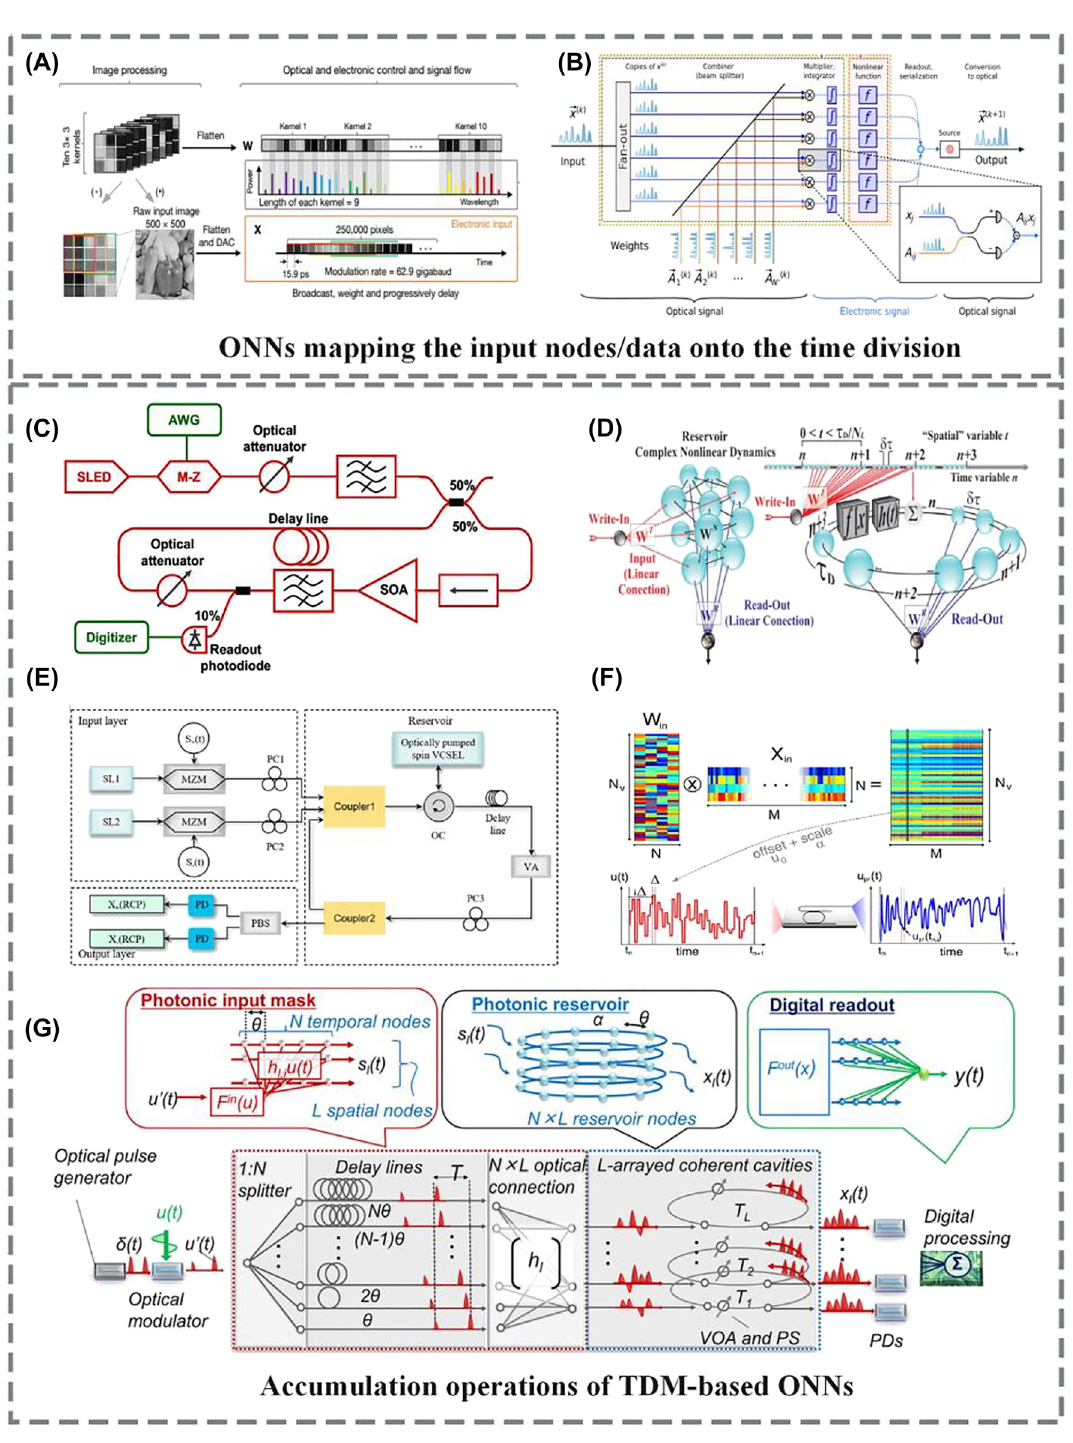
Figure 6: Advances in TDM-based ONNs. (A) and (B) ONNs exploiting TDM to implement large-scale fan-in/-out [39, 54]. (C) Time-delay reservoir computing (TD-RC) based on SOA [137]. (D) TD-RC based on electro–optic phase-delay oscillator [139]. (E) TD-RC based on an optically pumped spin VCSEL [141]. (F) TD-RC based on a silicon microring [142]. (G) Scalable RC on coherent linear photonic processor